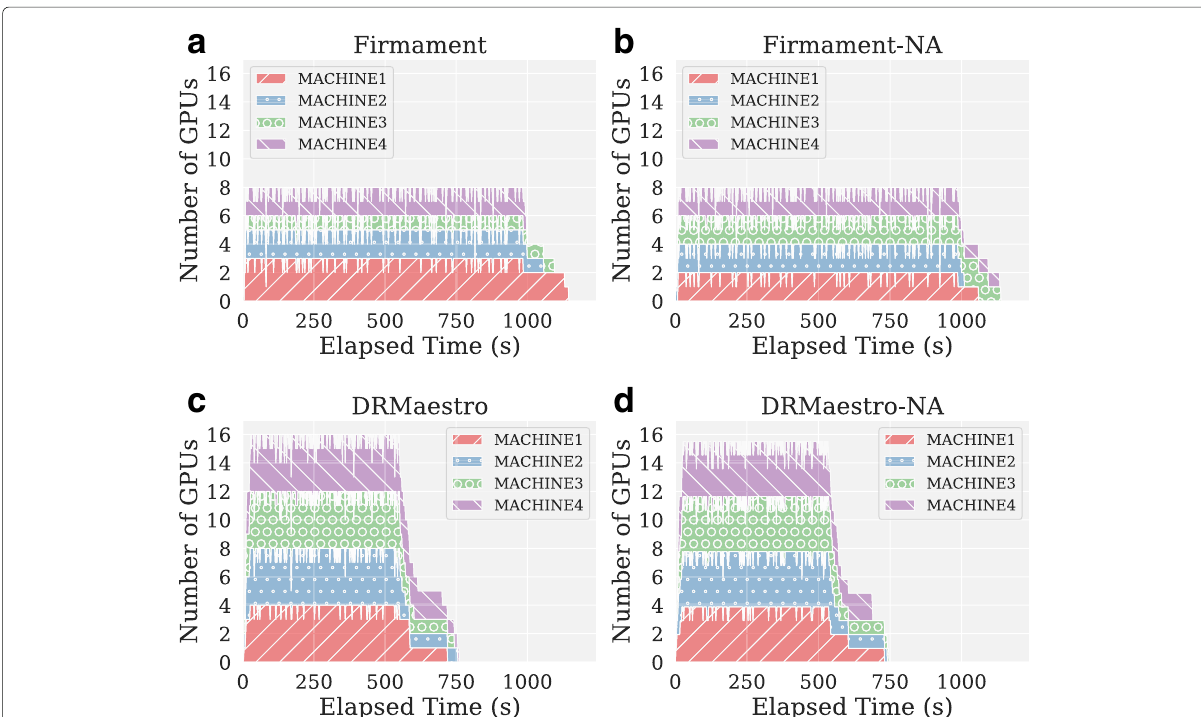
Fig. 4 Experiment results of orchestration with DRMaestro . Orchestration performed with DRMaestro with the implemented prototype in a cluster with 4 machines and 128 jobs